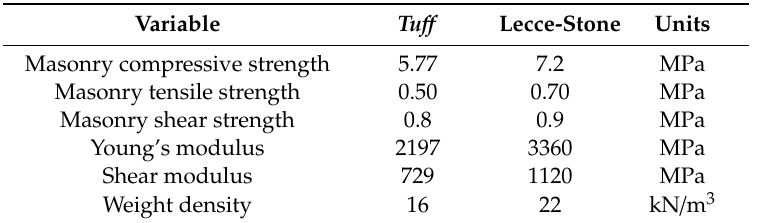
Table 1. Masonry properties.